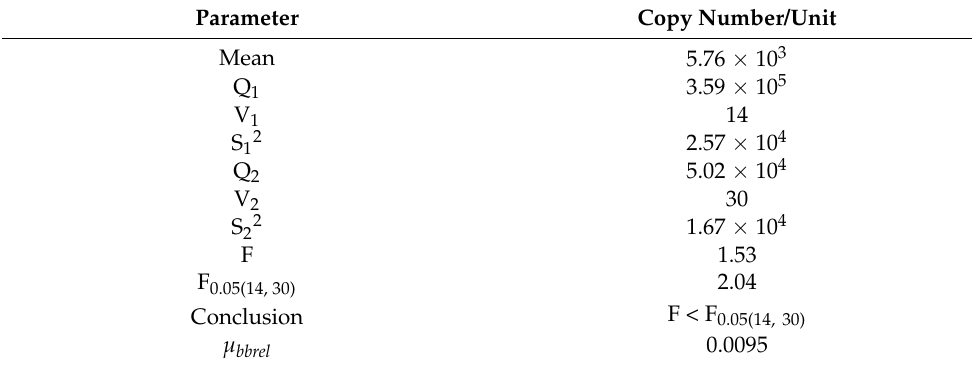
Table 1. Results of the homogeneity